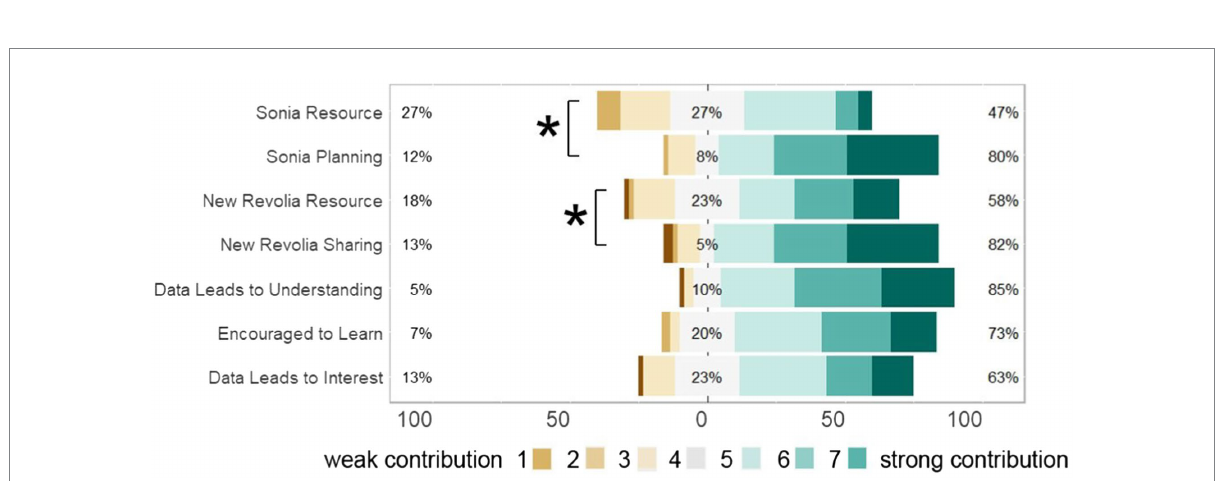
FIGURE 7 Quantitative results from survey on 1–7 Likert scale. Sonia.Resource—“How strongly does the Sonia McDougal story contribute to an understanding of development of resources?” Sonia.Planning—“How strongly does the Sonia McDougal story contribute to an understanding of prioritizing long term planning?” New.Revolia.Resource—“How strongly does the New Revolia story contribute to an understanding of resource limitations?” New.Revolia.Sharing—“How strongly does the New Revolia story contribute to an understanding of sharing amongst diverse groups?” Data.Leads.to.Understanding—“How strongly do the four panels with specific climate change data and facts contribute to your realization of the urgent situation of climate change?” Encouraged.to.Learn—“How encouraged are you by the data shown in the manga pages to learn about climate change?” Data.Leads.to.Interest—“How strongly do you think this data in comics contributes to your interest in climate change evidence?” Sonia Resource responses differ significantly from Sonia Planning; New Revolia Resource responses differ significantly from New Revolia Sharing (Wilcoxon ranked sum, p <